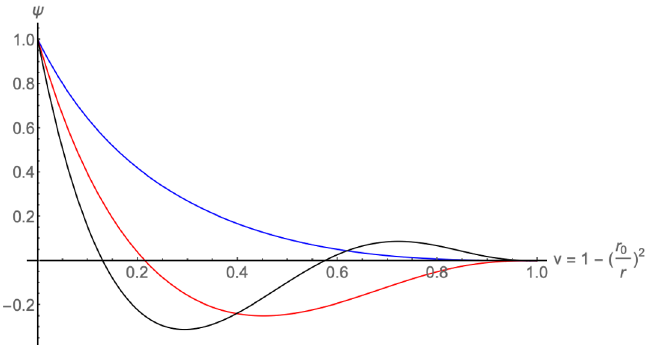
Figure 1 . Wave functions of the first three scalar modes in Witten’s model (here normalized such that ψ (0) = 1